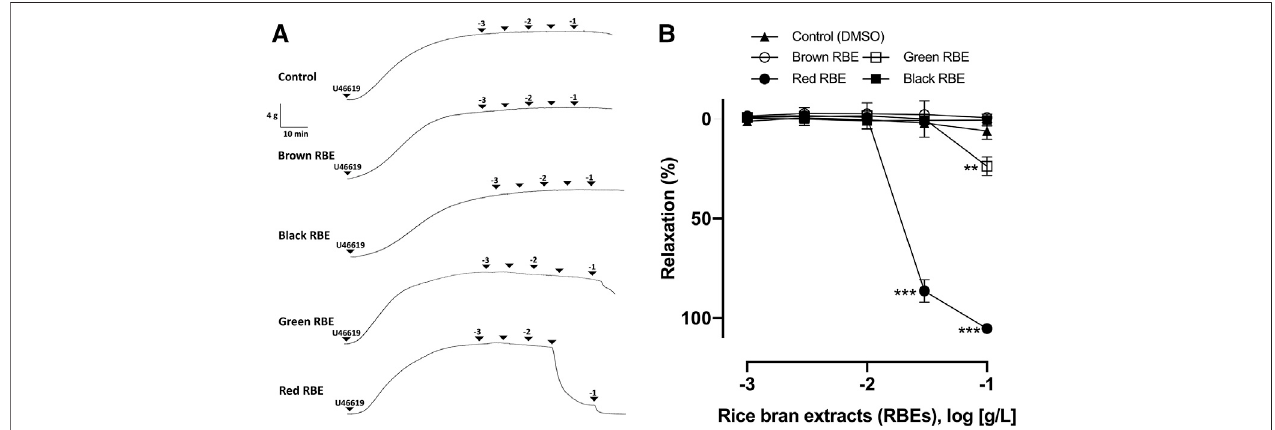
FIGURE 1 | Characterization of vasorelaxation in four pigmented RBEs in porcine coronary artery rings. Arterial rings with the endothelium were contracted with U46619 before the addition of increasing concentrations ofred, brown, green, and black RBEs (1 μ g/ml to 100 μ g/ml) to construct the concentration-relaxation curves. (A) Representative original tracing and (B) corresponding cumulative concentration-relaxation curve. The relaxation response is expressed as the percentage relaxation of the U46619-induced contraction. Results are presented as means ± SEM ( n = 6 – 8). *** p < 0.001 vs control. ** p < 0.01 vs control.